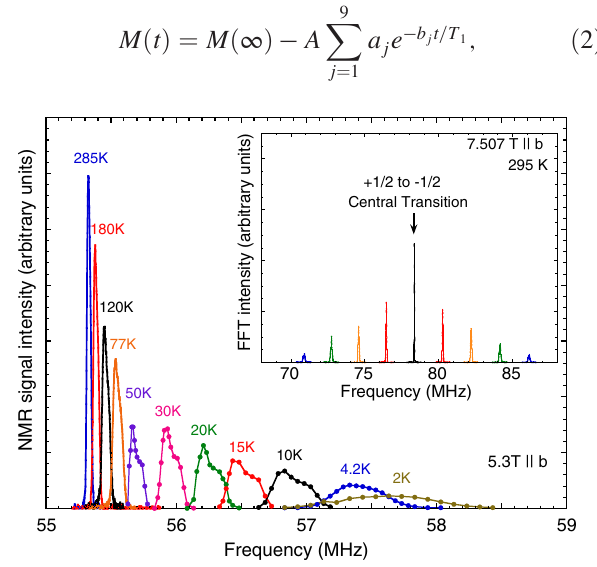
FIG. 3. The temperature dependence of the 93 Nb NMR line ¼ þ 1 shape observed for the central transition between the I 2 z and − 1 energy levels in h ⊥ ¼ 5 . 3 Tesla applied along the b 2 axis. We obtained the line shapes using the FFT of the spin- FIG. 4. Examples of the recovery of the spin-echo intensity, echo signal above 77 K. For the broader line shapes below M ð t Þ , observed for the central and fourth satellite transitions at 77 K, we measured the integral of the spin echo as a function 130 K in h ⊥ ¼ 3 Tesla. For comparison, we normalized the of the frequency. Inset: The 93 Nb NMR line shape at 295 K recovery curves by plotting 1 − ½ M ð ∞ Þ − M ð t Þ(cid:2) =A as a function observed at 7.507 T using the FFT of spin-echo signals. The of t . The solid lines represent the best fit with 1 =T 1 ¼ 1 . 99 × 10 3 s − 1 for the central transition and 1 =T ¼ 1 . 96 × 10 3 s − 1 for largest peak in the middle is the central transition, and four 1 ¼ m to m þ 1 additional pairs of weaker peaks arise from I the fourth satellite transition, as described in the text. Also plotted z transitions ( m ¼ − 9 = 2 , − 7 = 2 , − 5 = 2 , − 3 = 2 , þ 1 = 2 , þ 3 = 2 , is the recovery curve observed for the fourth satellite peak at 2 K þ 5 = 2 , and þ 7 = 2 ). in h ⊥ ¼ 5 . 2